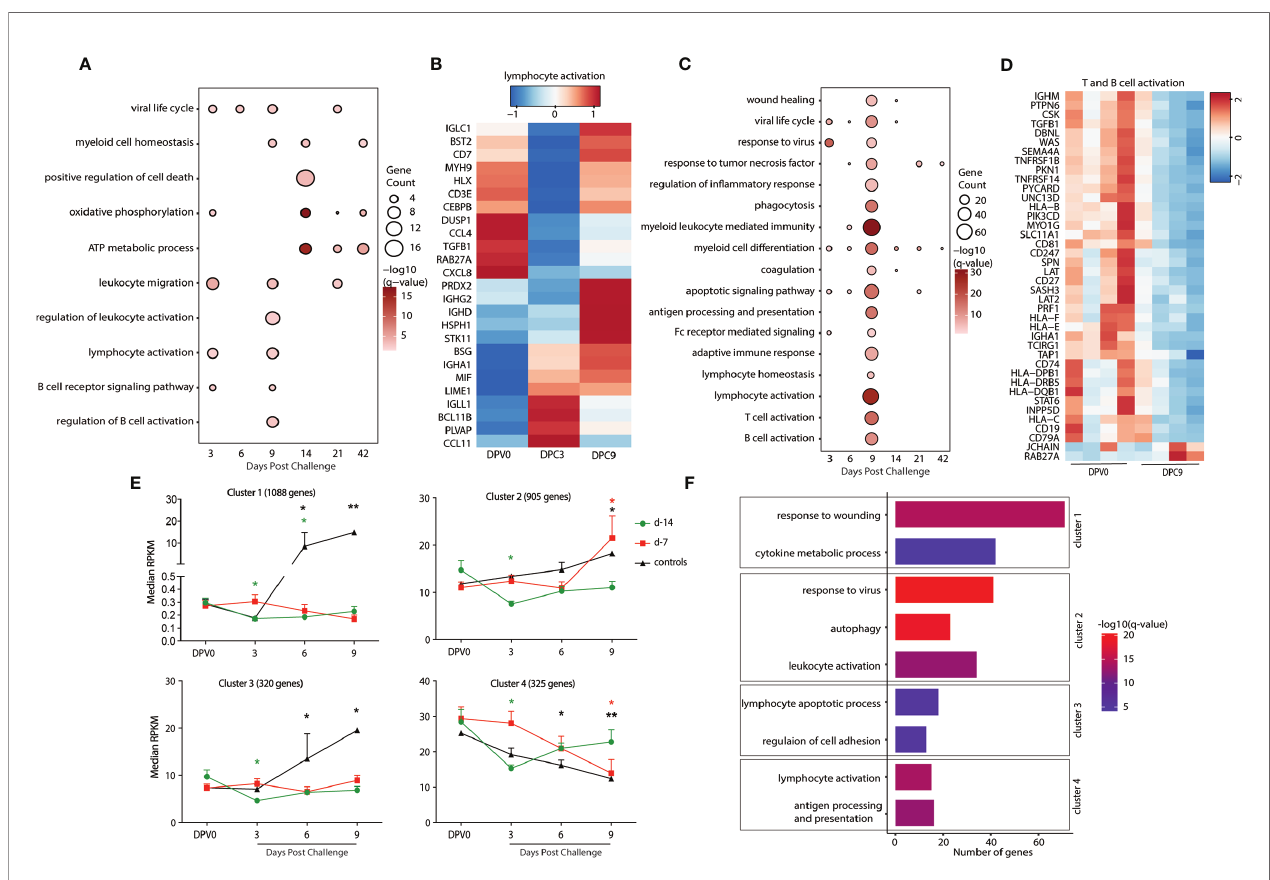
FIGURE 4 | Animals vaccinated as early as 7 days prior to challenge generate a recall adaptive immune response. (A, C) Functional enrichment of DEGs post VSV- MARV challenge (A) day -14 group and (C) day -7 group; each bubble represents a Gene Ontology (GO) term and the size of each bubble represents number of DEGs enriching to that GO term while color intensity represents the statistical signi fi cance (shown as – log 10 of the q-corrected p-value). (B, D) Heatmap of DEGs post VSV-MARV challenge enriching to (20) “ lymphocyte activation ” , “ T cell activation ” , and “ B cell activation. ” Each column represents the median normalized transcript counts (RPKM) for each gene at each time point. The range of colors is based on scaled and centered RPKM values of the entire set of genes, with red indicating highly expressed genes and blue indicating lowly expressed genes. (E) maSigPro analysis identi fi ed four distinct and signi fi cant temporal expression clusters of genes. The median RPKM of each cluster over time is plotted. Statistical signi fi cance among time points was determined using one-way ANOVA with Dunnett ’ s multiple-comparison test relative to 0 DPV. Statistical signi fi cance is indicated as **p<0.01, and *p<0.05. (F) Functional enrichment of the four clusters presented in (E) . Horizontal bars represent the number of genes mapping to each GO term with color intensity representing the negative log of the FDR-adjusted p-value